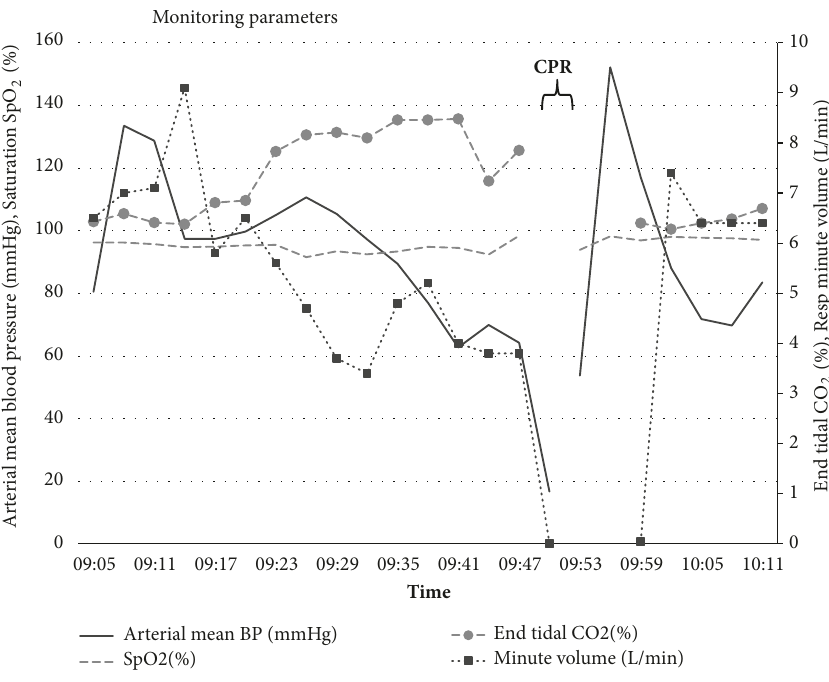
Figure 3: Vital parameters. Preceding the second cardiac arrest, expired minute volume is reduced, resulting in elevated end tidal carbon dioxide concentration. Blood pressure is initially elevated, probably secondary to stress, before it suddenly drops. Saturation is maintained through increased oxygen fraction in inspired